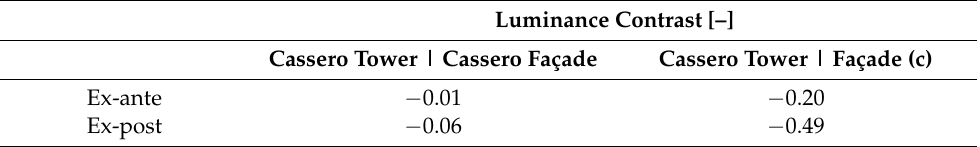
Table 20. Observation point I1. Luminance